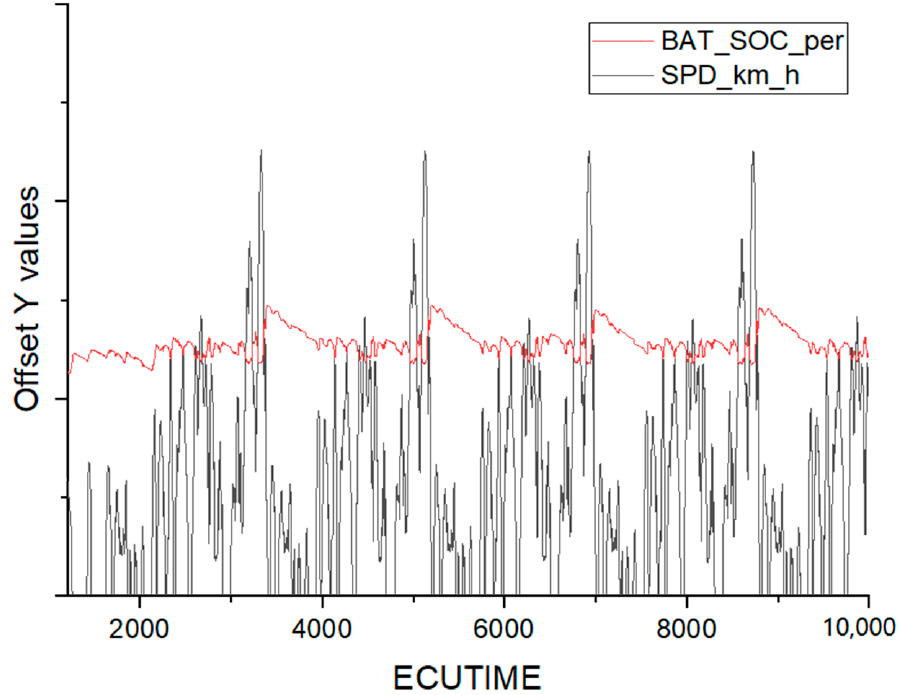
Figure 12. Comparison between speed and change of SOC.